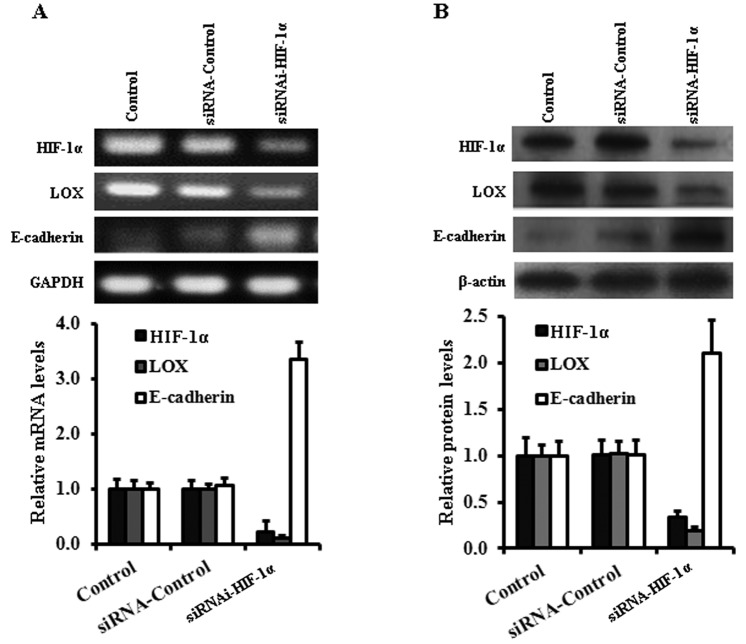
LOX is HIF-1α-dependent and negatively regulates E-cadherin expression. (A) Representative RT-PCR analysis showing the effect of HIF-1α knockdown on LOX and E-cadherin mRNA expression in SKOV-3 cells; the histogram shows the mean level of mRNA determined from 3 independent experiments expressed as the fold-change relative to that in the untreated control cells after normalization to GAPDH. (B) Representative western blotting showing the effect of HIF-1α knockdown on LOX and E-cadherin protein expression in SKOV-3 cells; the histogram shows the mean level of the protein determined from 3 independent experiments expressed as the fold-change relative to that in the untreated control cells after normalization to β-actin. LOX, lysyl oxidase.